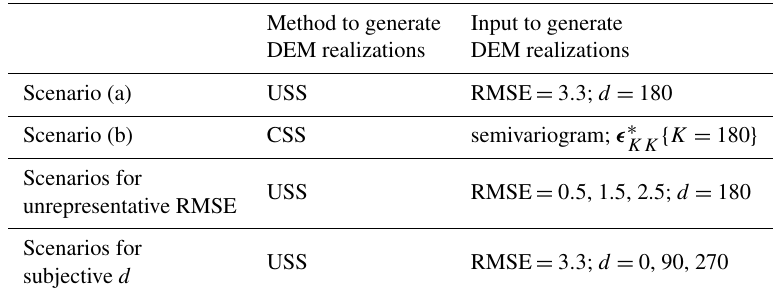
{ K = 180 } of the HK-DTM at 180 reference locations. The background is the hillshade plot of the HK- Figure 3. (a) Elevation error (cid:15) ∗ KK DTM. Debris-resisting barriers and a road in the area indicated by the red ellipse and blue rectangle constructed after the 2008 landslide event are represented in the HK-DTM but not in the 2m-DEM. It causes inconsistency between the two DEMs in that area. To avoid an unrealis- tically large error in the HK-DTM, data from the 2m-DEM in that area are excluded from higher-accuracy reference data. (b) Histogram of { K = 180 } . The RMSE is larger than the standard deviation ( σ ) since the mean ( µ ) is not zero. As discussed in Sect. 3.1, this indicates (cid:15) ∗ KK that assuming the standard deviation of the HK-DTM error to be equivalent to the RMSE in USS would overestimate the variability in the HK-DTM error. Table 1. Scenarios for stochastic simulation.